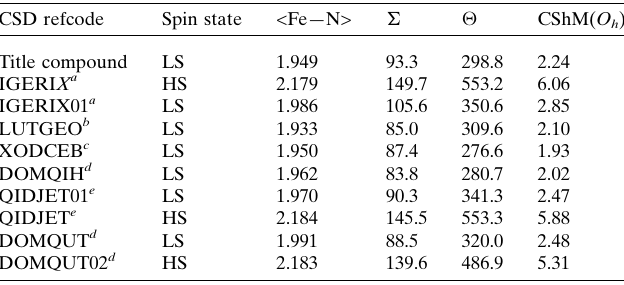
Table 2 Computed distortion indices (A˚ , (cid:4) ) for the title compound and similar complexes reported in the